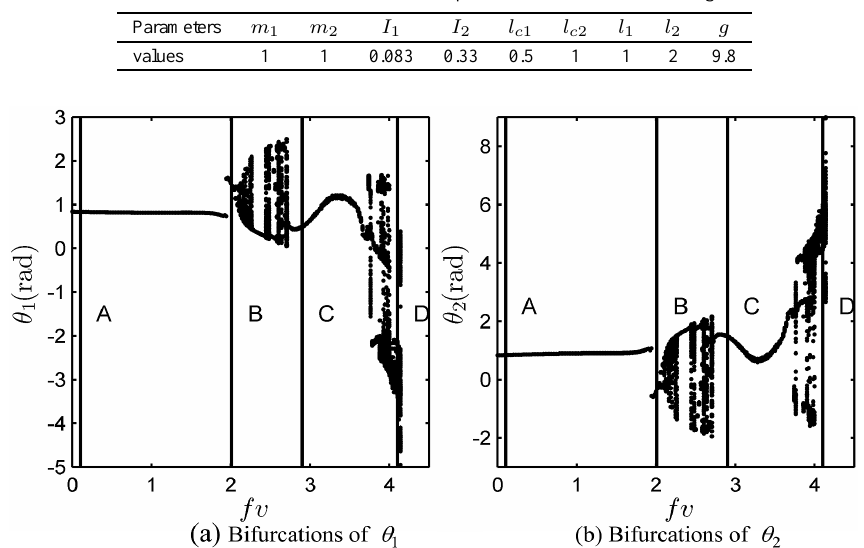
Table 1 The dimensionless values of structural parameters of the two-bar linkage